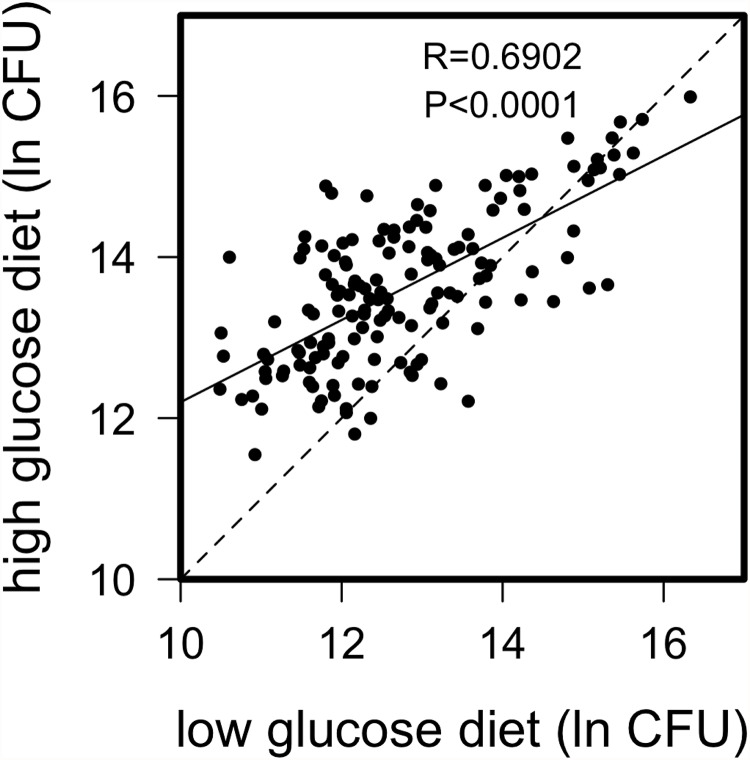
Correlation of natural log bacterial load (CFU) 24-hours post infection for DGRP lines raised on high glucose and low glucose diets.Dashed line represents 1 to 1 relationship; solid line from regression analysis. There is strong correlation across diets, but several lines appear to perform disproportionately poorly (i.e. carry high bacterial load) on the high glucose diet. A natural log value of 10 corresponds to about 2.2x104 bacteria, 12 corresponds to about 1.6x105 bacteria, 14 corresponds to 1.2x106 bacteria and 16 corresponds to 8.9 x106 bacteria.